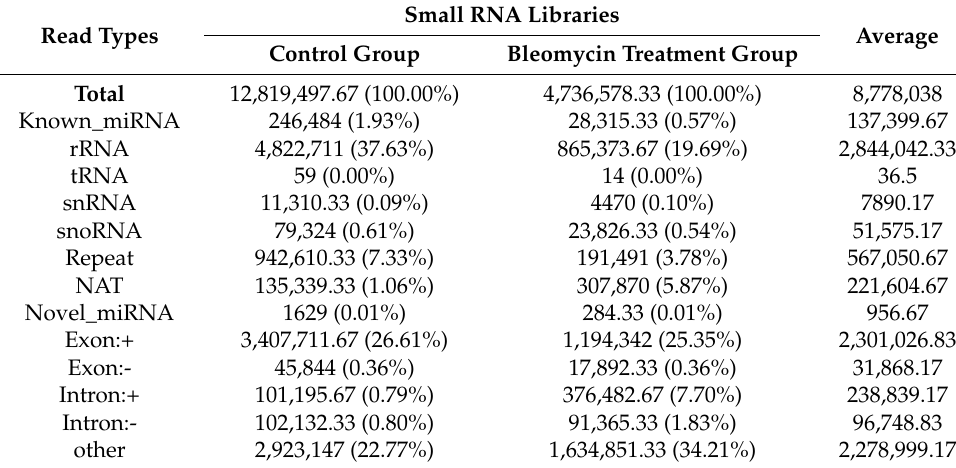
Table 2. Classification of small RNAs identified in rice roots.